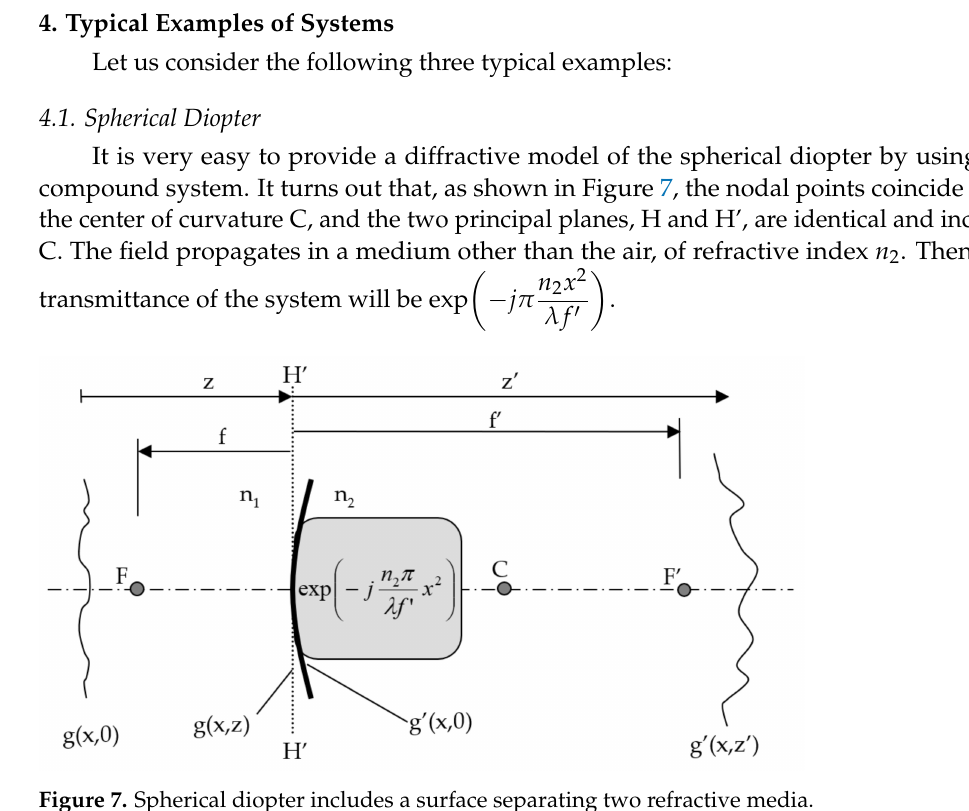
Figure 7. Spherical diopter includes a surface separating two refractive